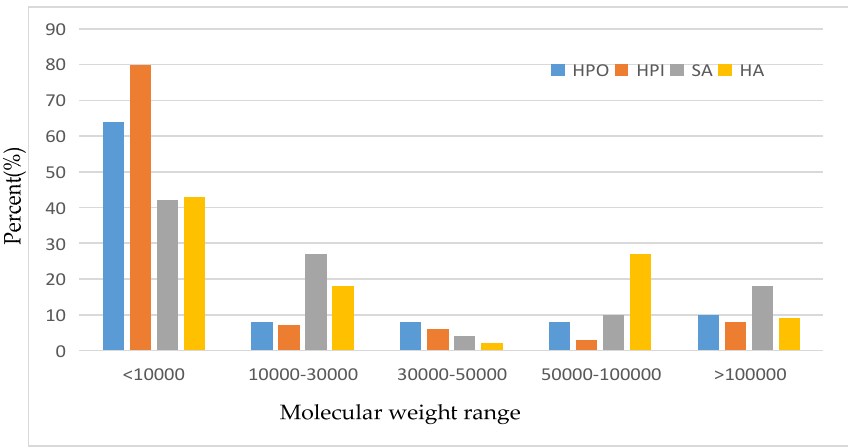
Figure 1. Molecular weight distribution of different organic matters in secondary treated effluent. (Note: HPO-hydrophobic; HPI-hydrophilic; SA-sodium alginate; HA-humic acid). (Note: HPO-hydrophobic; HPI-hydrophilic; SA-sodium alginate; HA-humic